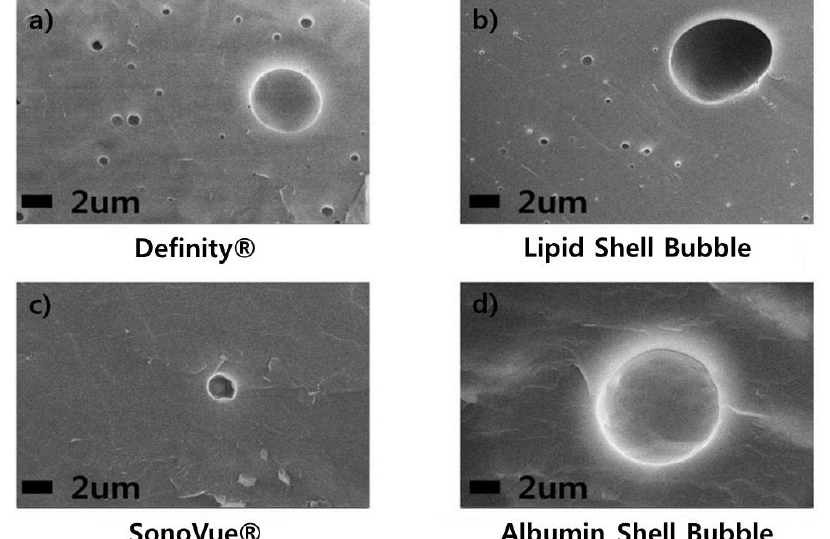
Figure 1. Cryo-SEM images of UCAs. Mirco-size circular bubbles can be observed in all four